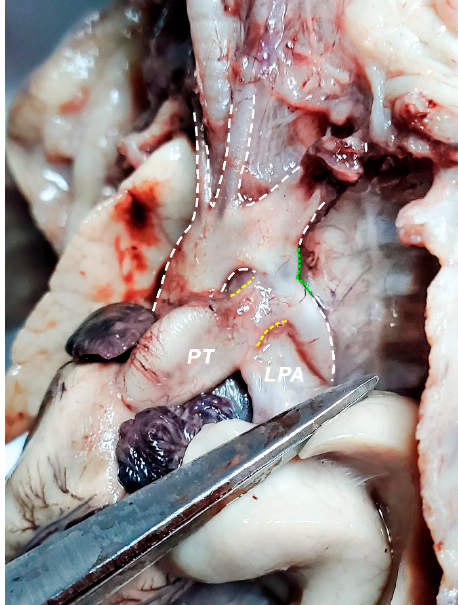
Figure 11. Mediastinum, heart and greater vessels; left view; left lung was pulled inferiorly in order to highlight left pulmonary artery (LPA) and ductus arteriosus (yellow dashed lines). Green dashed line highlights the aortic coarctation, situated distally from the left subclavian artery emergence situs. Ductus arteriosus appears wide in dimension; it emerges on the anterior aspect of the pulmonary trunk (PT) and ends at the level of the aortic narrowing. LPA emerges posterior from the ductus arteriosus and is put into tension by the dissection instrument in the picture. Thus, a right angle between PT and LPA is noticeable in the figure due to the traction we exerted on the left pulmonary hilum. The left subclavian artery gives the impression of a rather terminal branch of the aorta, appearing almost as wide as the aortic arch